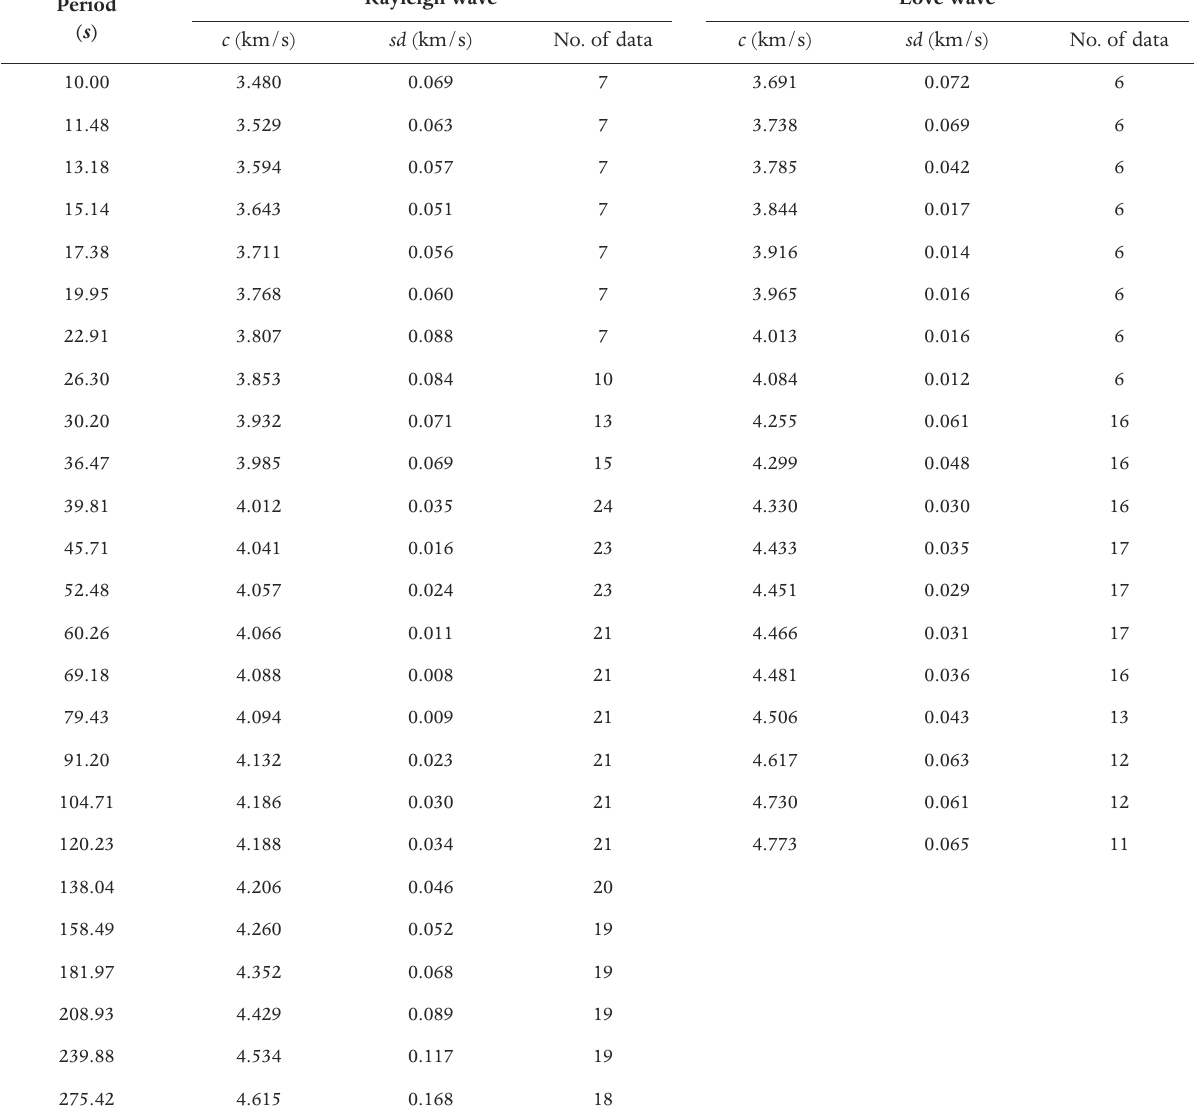
Figure 4 (left). Observed mean phase velocities of Rayleigh and Love waves are shown by small circles and triangles; vertical grey lines through these symbols show ± one standard deviation. The theo- retical curves for crust-upper mantle of Bastar craton (IP11BA, Bhattacharya et al. [2009]) and those of north Indian peninsula (NW-IP) (present study) are shown. The theoretical curves of Love waves for IP11BA and NW-IP (present study) are close to each other.